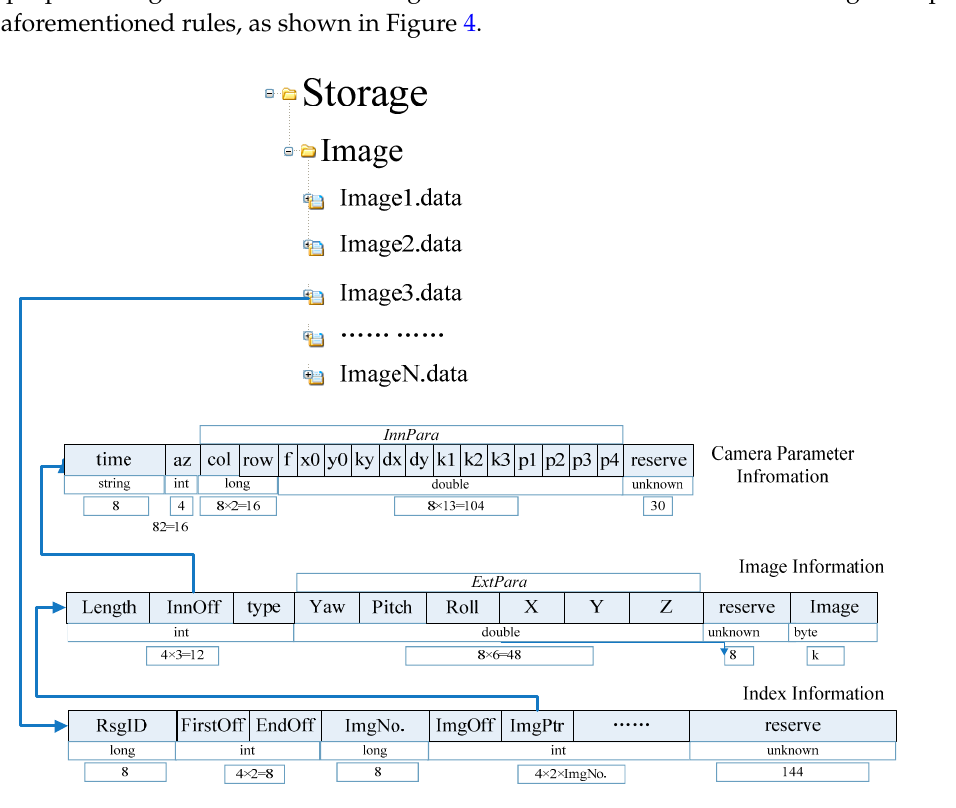
Figure 4. Large file-based data storage model for GRID.